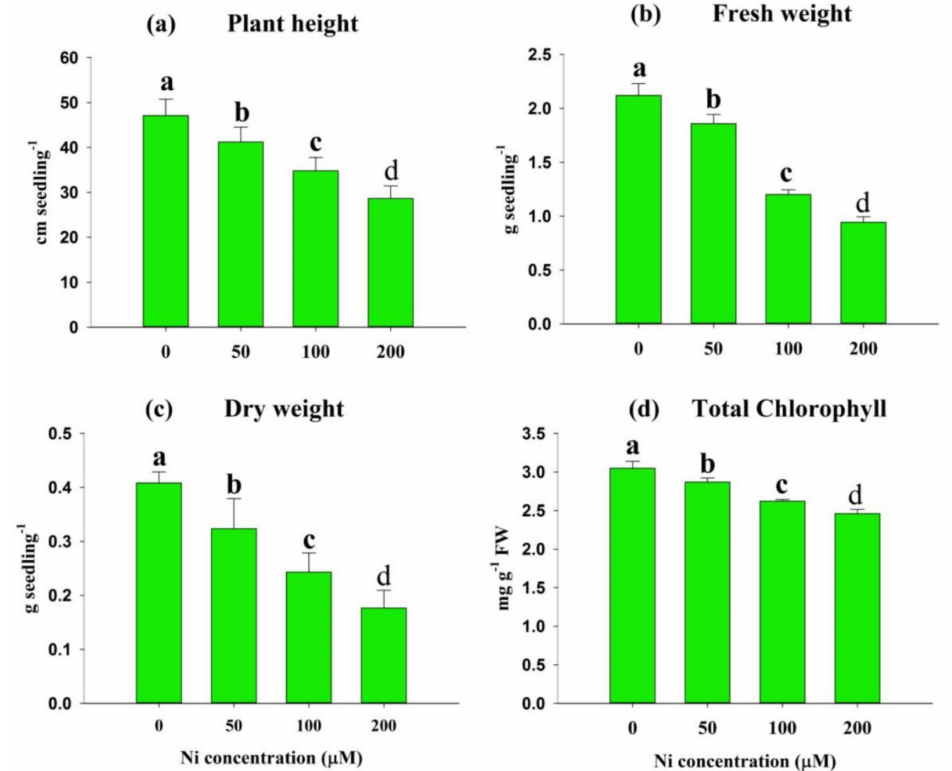
Figure 2. Effects of nickel (Ni) on plant height ( a ), fresh weight (FW) ( b ), dry weight (DW) ( c ), and the levels of total chlorophyll ( d ) in leaves of rice seedlings exposed to 0, 50, 100 and 200 µ M Ni for a period of 14 days. Bars represent means ± standard deviations (SDs) of three independent replications ( n = 3). Means followed by the same letter did not significantly differ among the treatments at p < 0.05, according to Fisher’s least significant difference test.